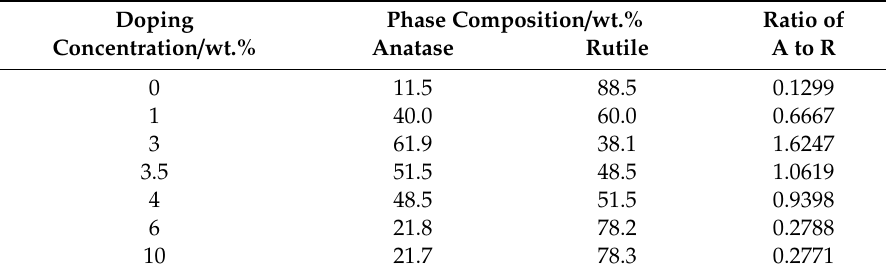
Table 2. Phase composition of di ff erent Ni doping content of TiO 2 nanofibers.